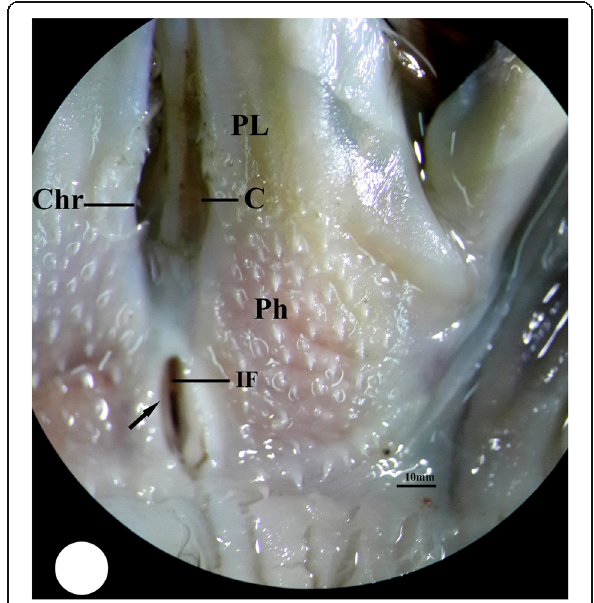
Fig. 3 Photomicrograph of the buccal cavity of hoopoe shows palate region (PL), choana (C), pharyngeal region (Ph), infundibular fissure (IF), choana ridges (Chr), and margins of infundibular fissure